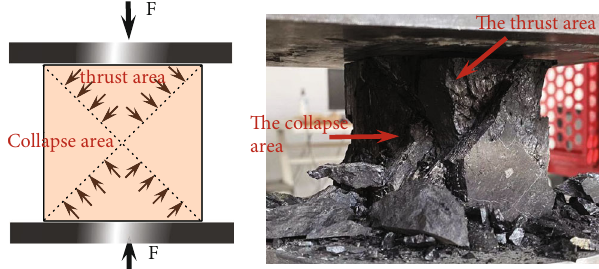
Figure 10: Shear slip surface under upper and lower constraints.